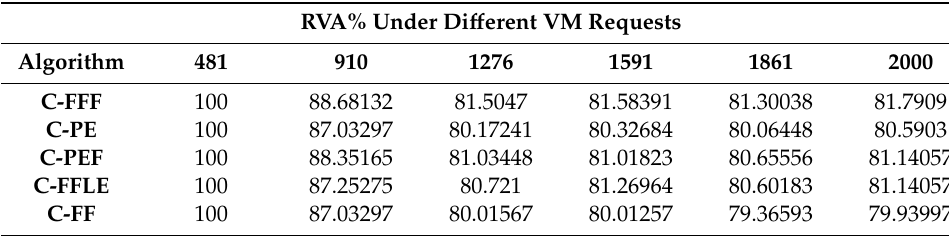
Table 8. RVA for all VM placement algorithms.